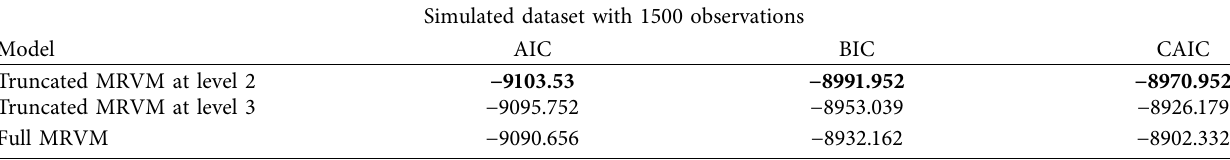
Table 7: Selection criteria values of the traditional, fixed, and new proposed models.